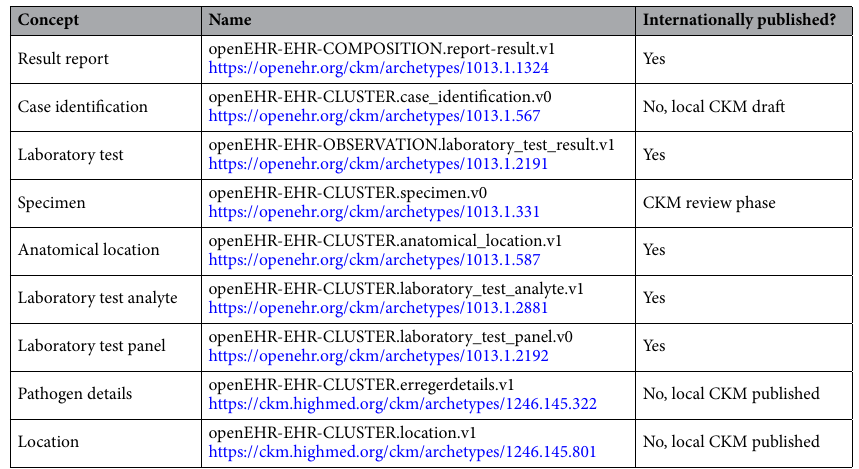
Table 1. Overview of archetypes used for representing microbiology data.